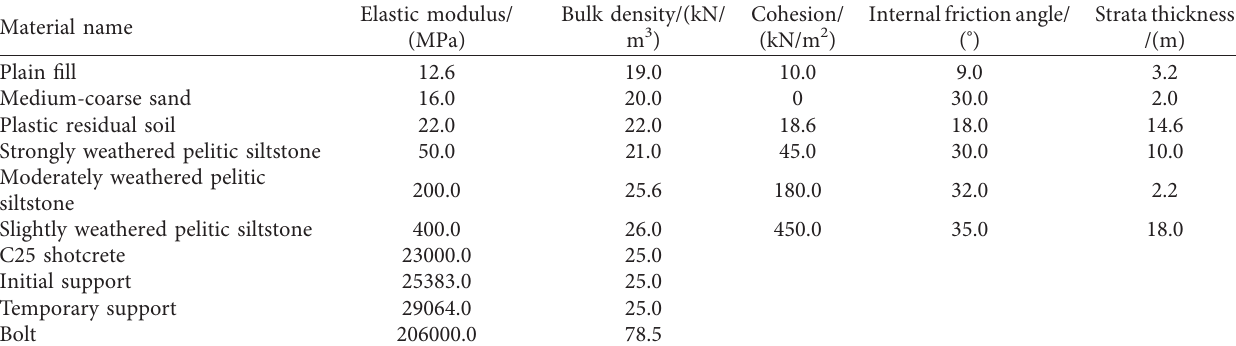
Table 1: Physicomechanical parameters of